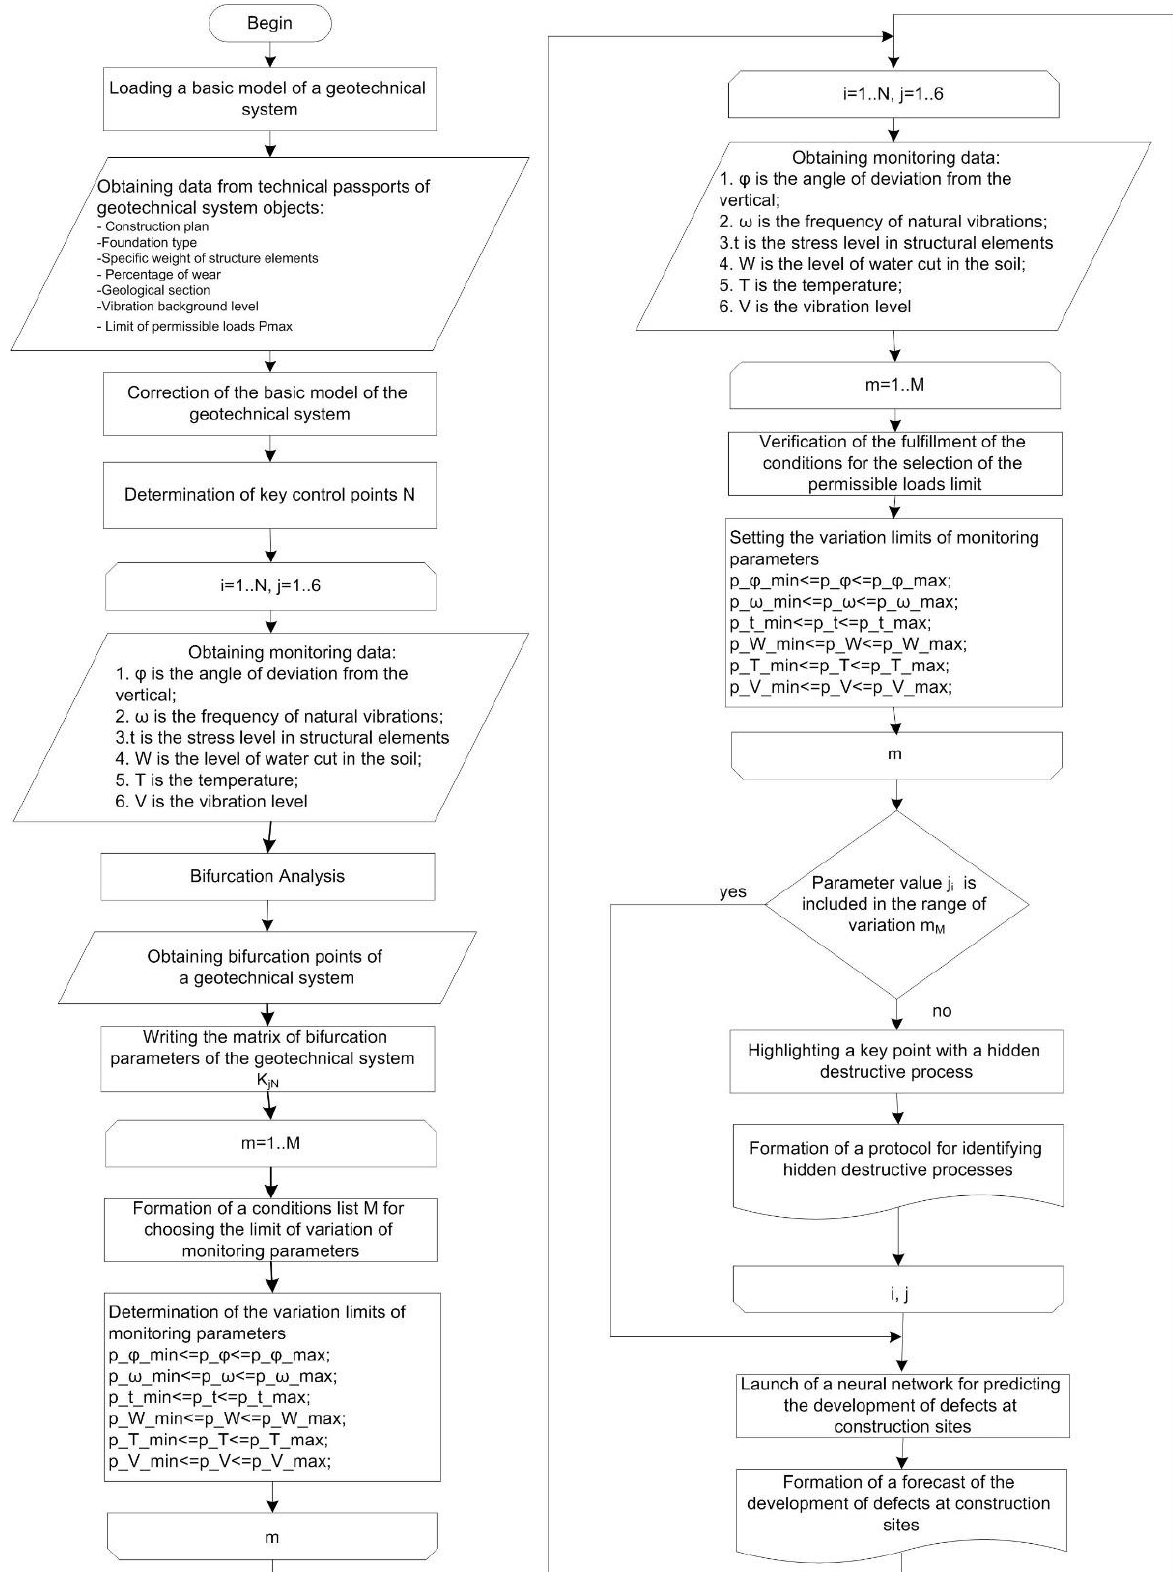
Figure 2. An identification algorithm for hidden destructive processes in geotechnical systems.